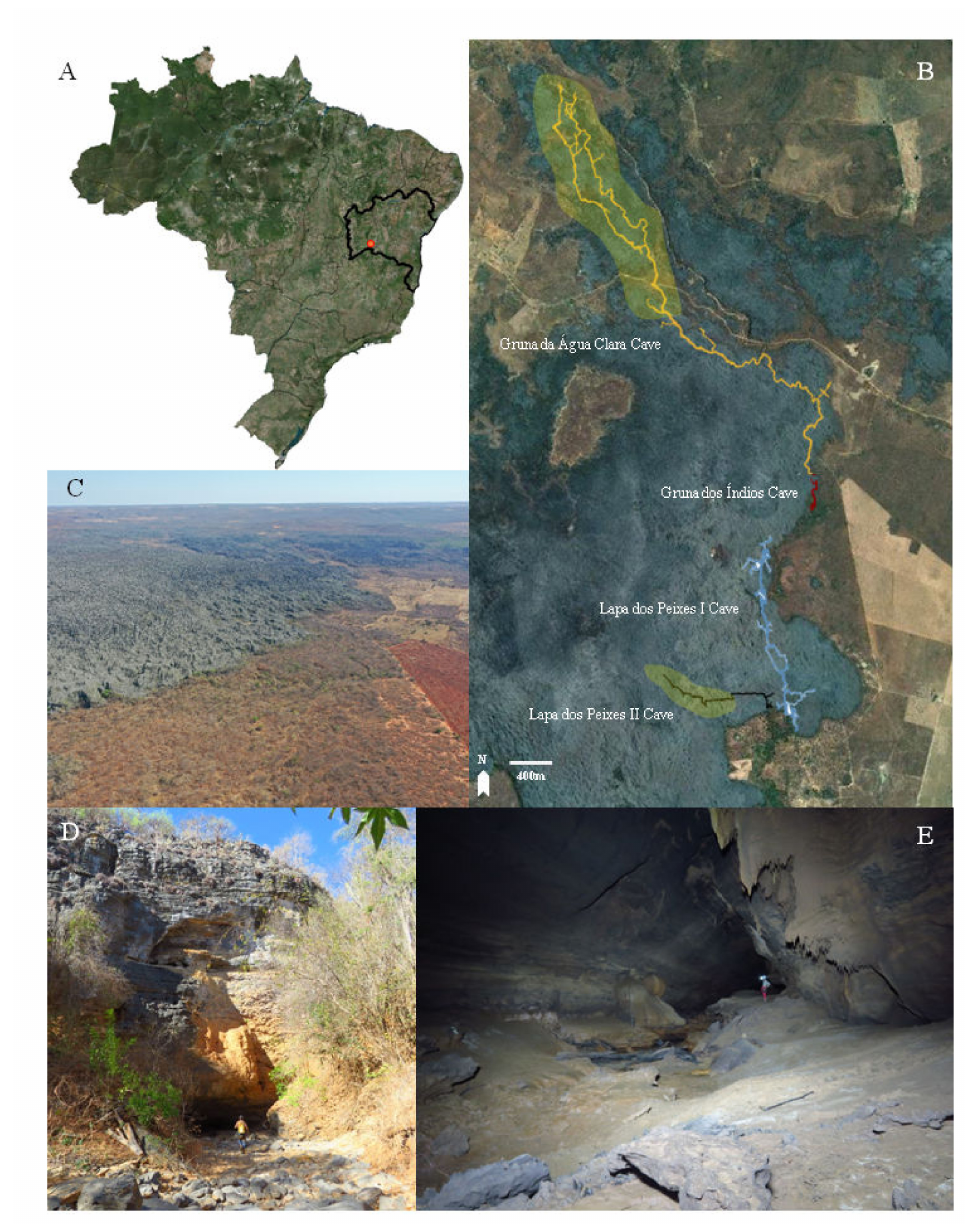
Figure 1. Type locality of Troglobentosminthurus luridus gen. nov. sp. nov.: ( A ) Á gua Clara cave system (ACCS) location, in the municipality of Carinhanha, Bahia state, Brazil; ( B ) spatial distribution of the caves within ACCS, the areas in translucent yellow correspond to the regions where the specimens of the new species were found; ( C ) aerial view from the surrounding region of the ACCS; ( D ) one of the entrances of the Gruna da Á gua Clara cave, which corresponds to a sink; ( E ) inner conduit of the Gruna da Á gua Clara